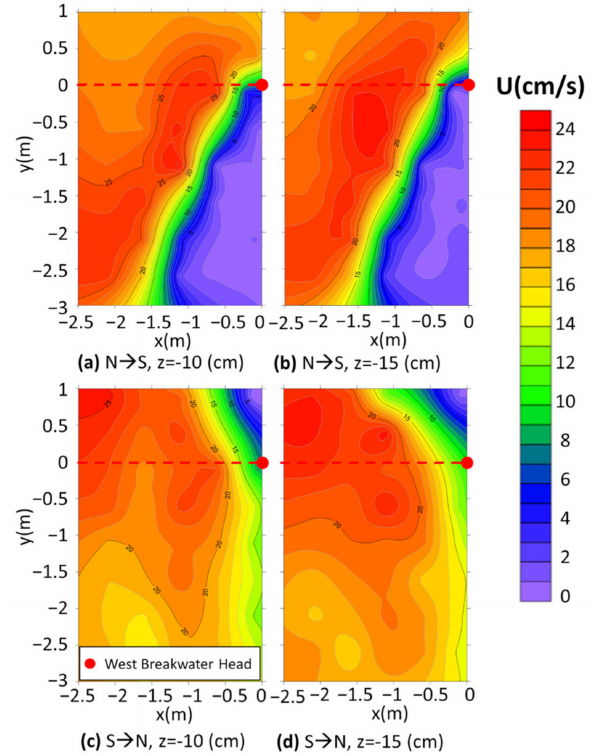
Figure 29. Current field at z = − 10 and z = − 15 under the action of